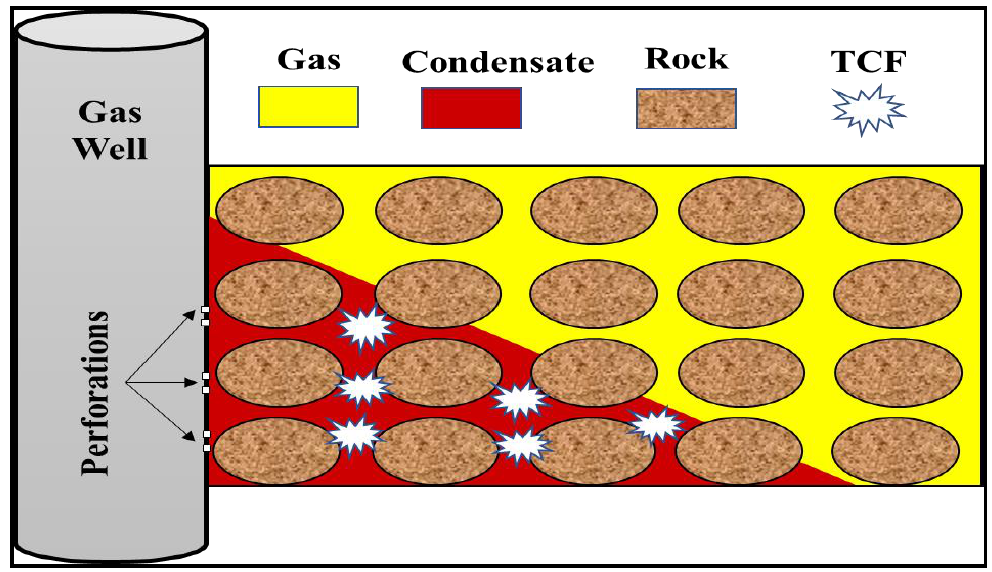
Figure 1. Proposed and experimentally proven technique for condensate-bank removal using thermochemical injection.